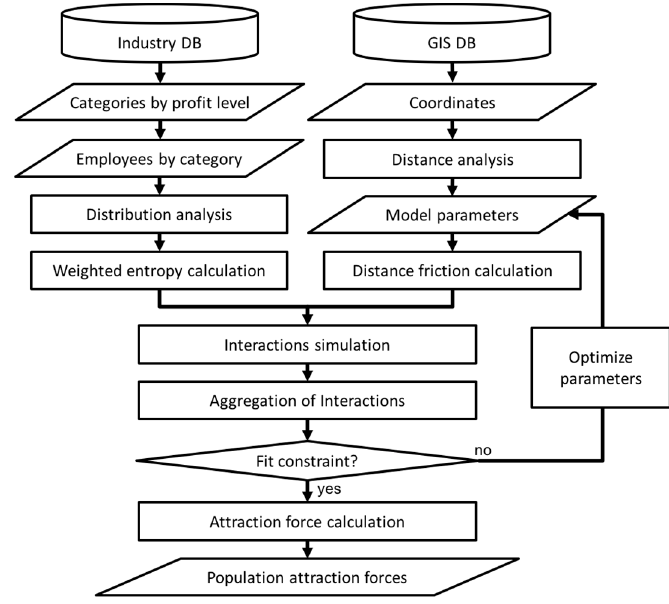
Figure 2. Process of attraction force evaluation.